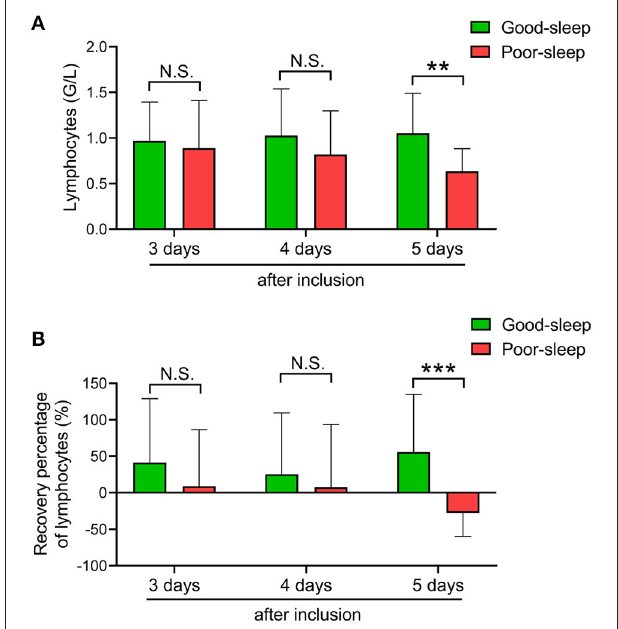
FIGURE 2 | Effects of short-term sleep deprivation on the recovery of absolute lymphocyte count (ALC) in septic intensive care unit patients. (A) Dynamic changes in ALC at 3, 4, and 5 days after inclusion in septic patients with good or poor sleep. (B) Dynamic changes in ALC recovery rate at 3, 4, and 5 days after inclusion in septic patients with good or poor sleep. Data are shown as mean ± SD. ** P < 0.01 and *** P < 0.001. N.S., not